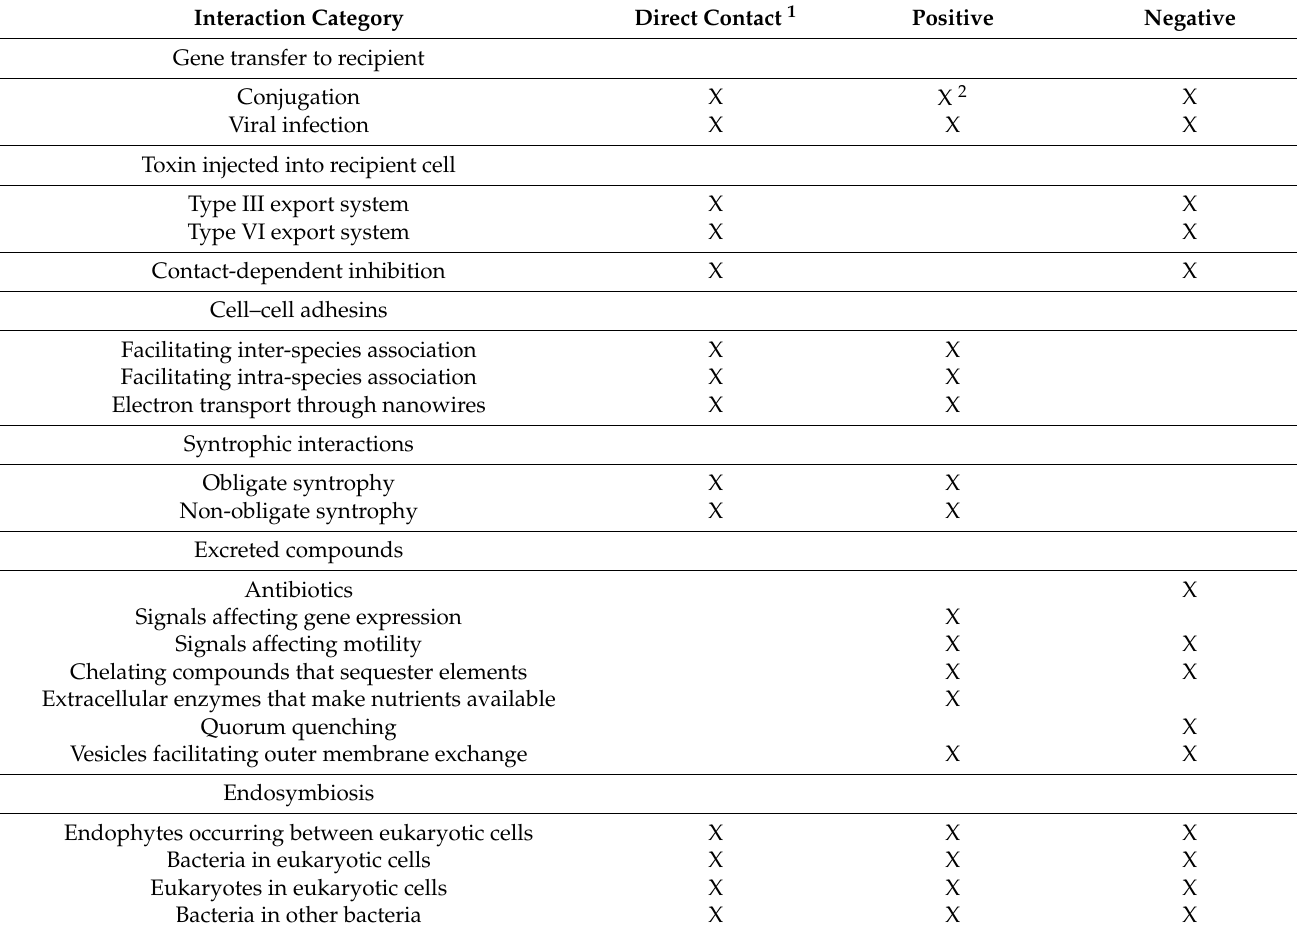
Table 1. Categories of microbe–microbe interactions reported to